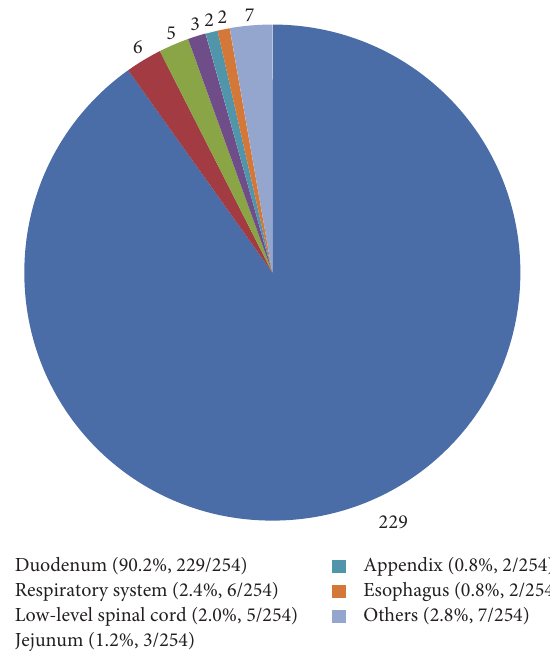
Figure 1: In the present literature survey, the duodenum was found to be the most common site of gangliocytic paraganglioma (90.2%, 229/254),followedbytherespiratorysystem(2.4%,6/254),low-level spinal cord (2.0%, 5/254), jejunum (1.2%, 3/254), esophagus (0.8%, 2/254), appendix (0.8%, 2/254), and others (2.8%, 7/254).